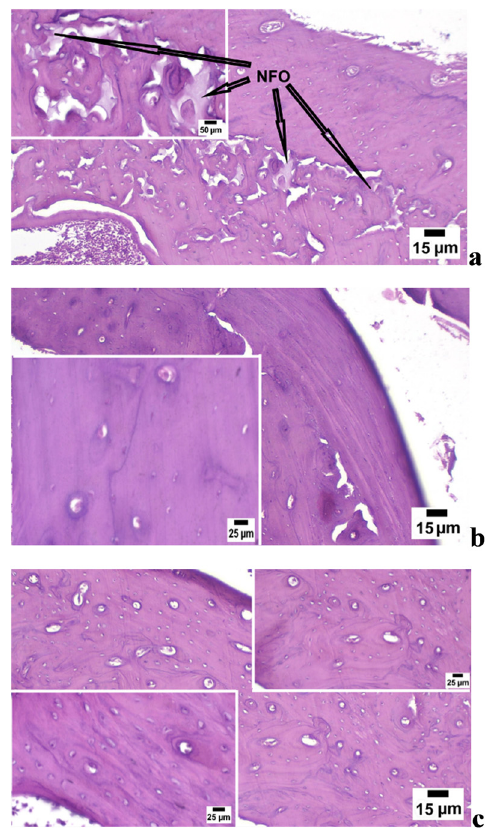
Figure 12: Light microscopic examination of ( a ) G0, ( b ) G0.25M and ( c ) G0.50M demonstrates nearly normal bone after 90 days of implantation. NFO: new formed